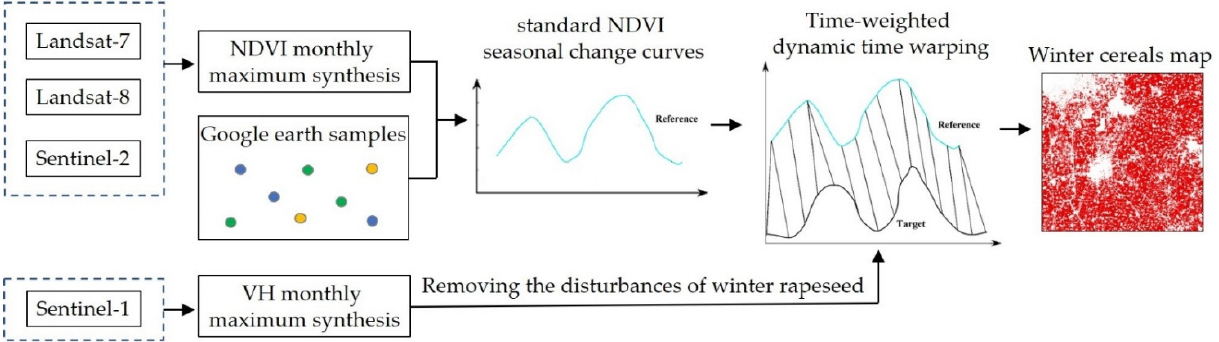
Figure 4. Flow chart of the methodology in this study for winter cereals classification.